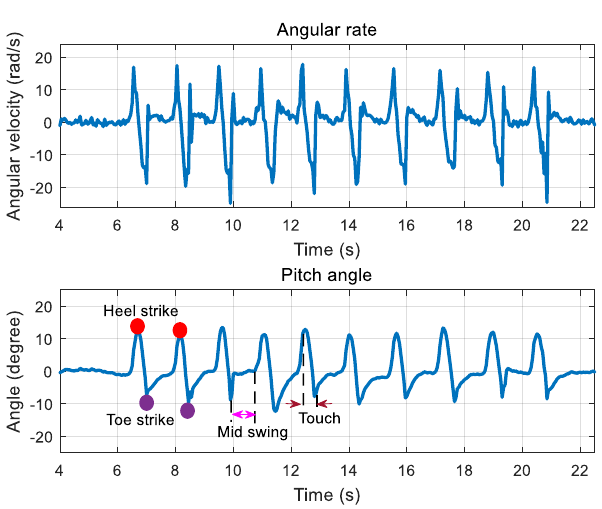
Figure 16. One gait cycle.